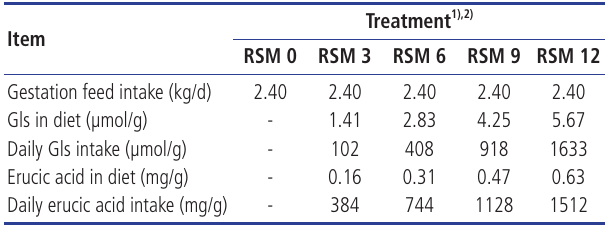
Table 3. Effect of rapeseed meal (RSM) supplementation levels in gestation diets on glucosinolates (Gls) and erucic acid intake in sows during gestation